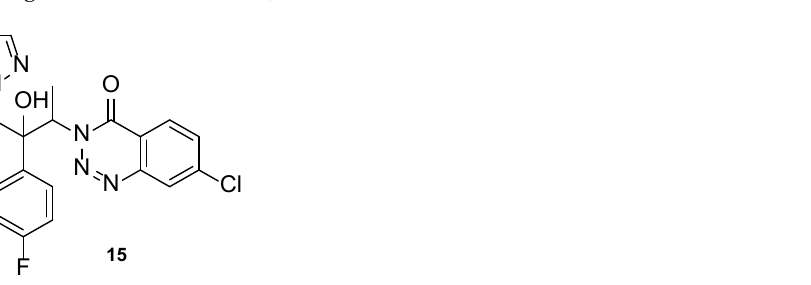
Figure 12. Chemical structure for compound 15 , novel triazole molecule designed based on alba- conazole ( 8 ) [60].